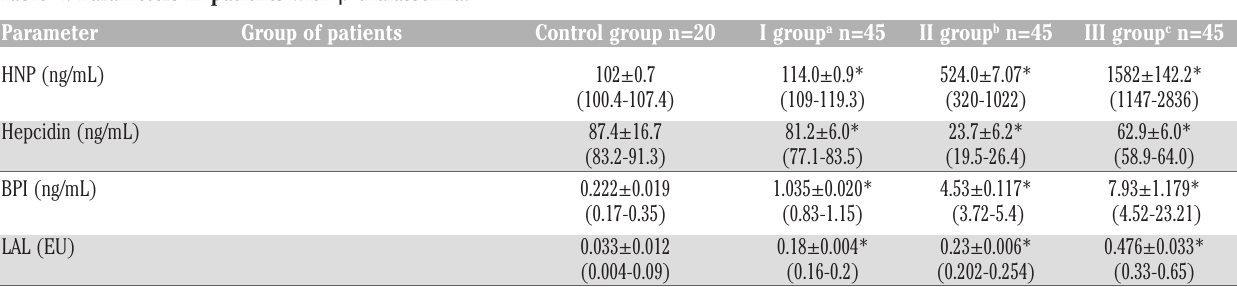
Table 2. Parameters in patients with β -thalassemia.